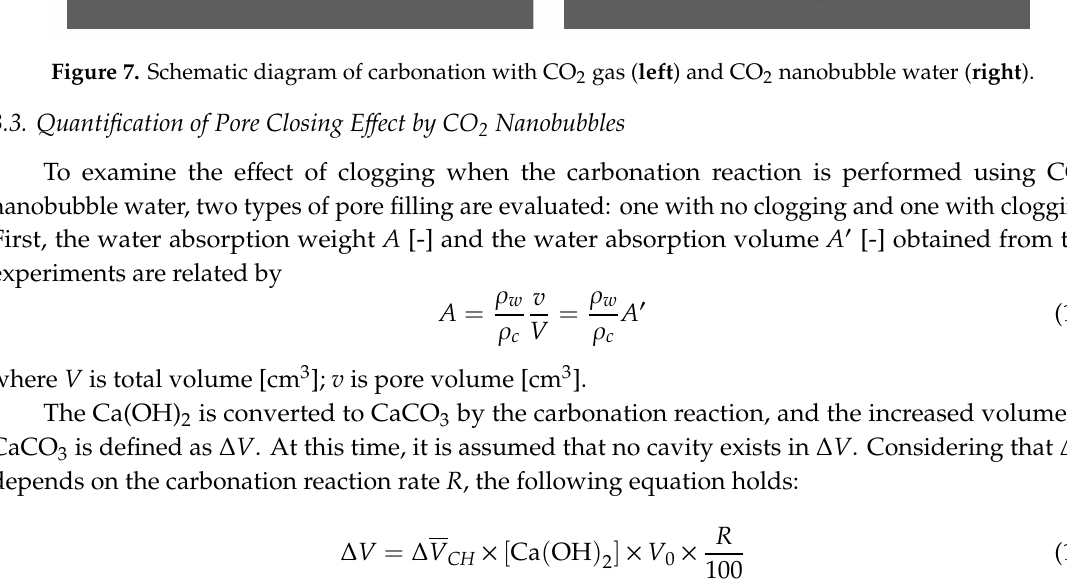
Figure 7. Schematic diagram of carbonation with CO 2 gas ( left ) and CO 2 nanobubble water ( right ).